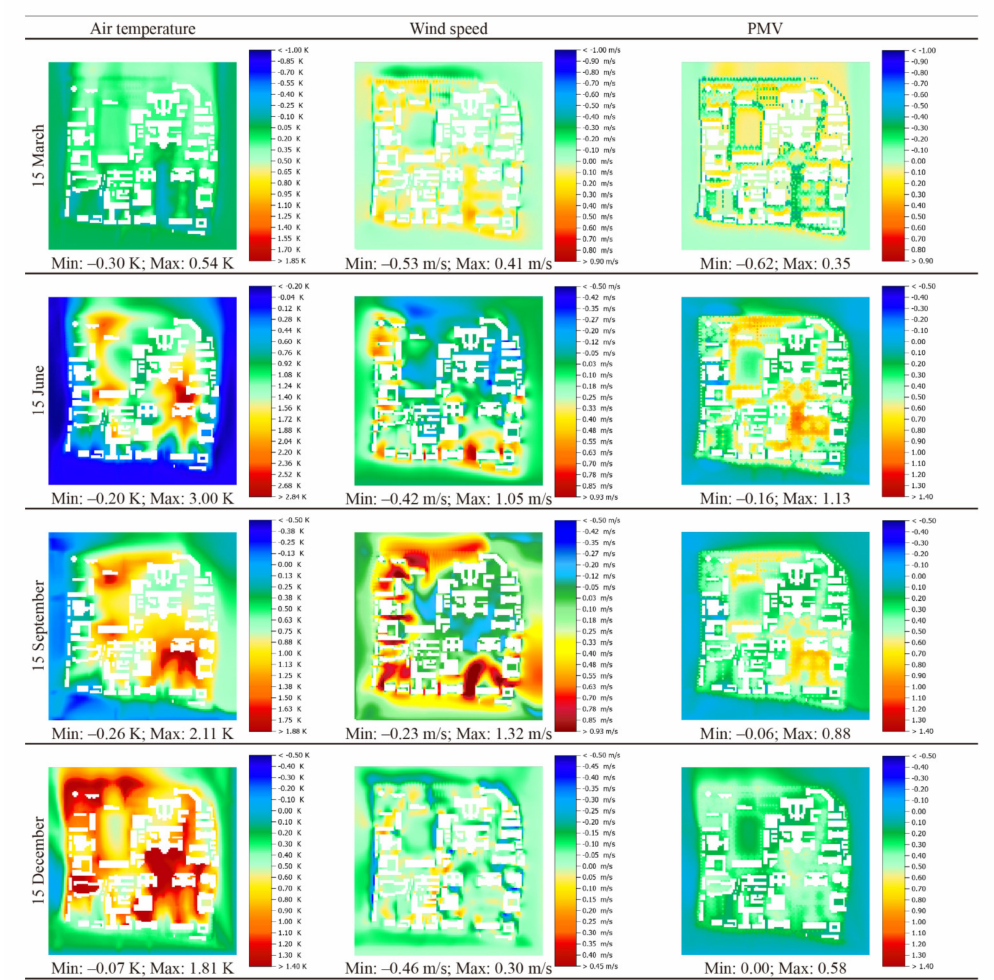
Figure 8. Comparative cloud maps of air temperature, wind speed, and PMV at a height of 1.2 m at 12:00 p.m. on four days. (Comparative results = Tree model simulation minus treeless model